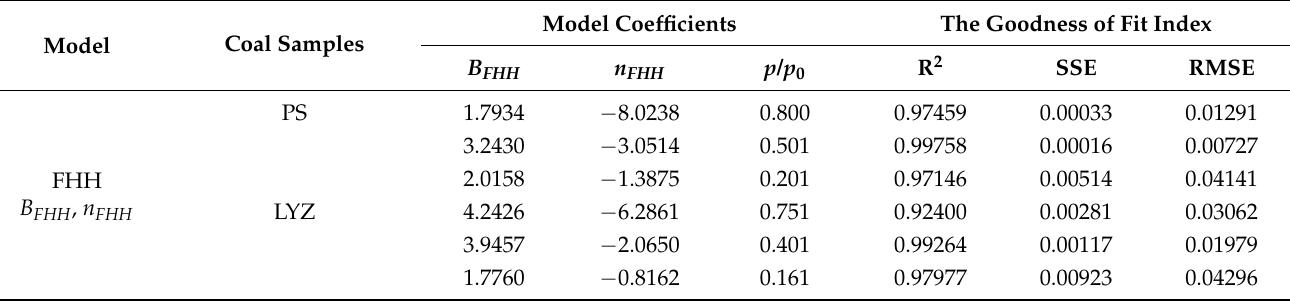
Table 2. FHH Modeling Parameters of Adsorption Isotherms of PS and LYZ coal samples.